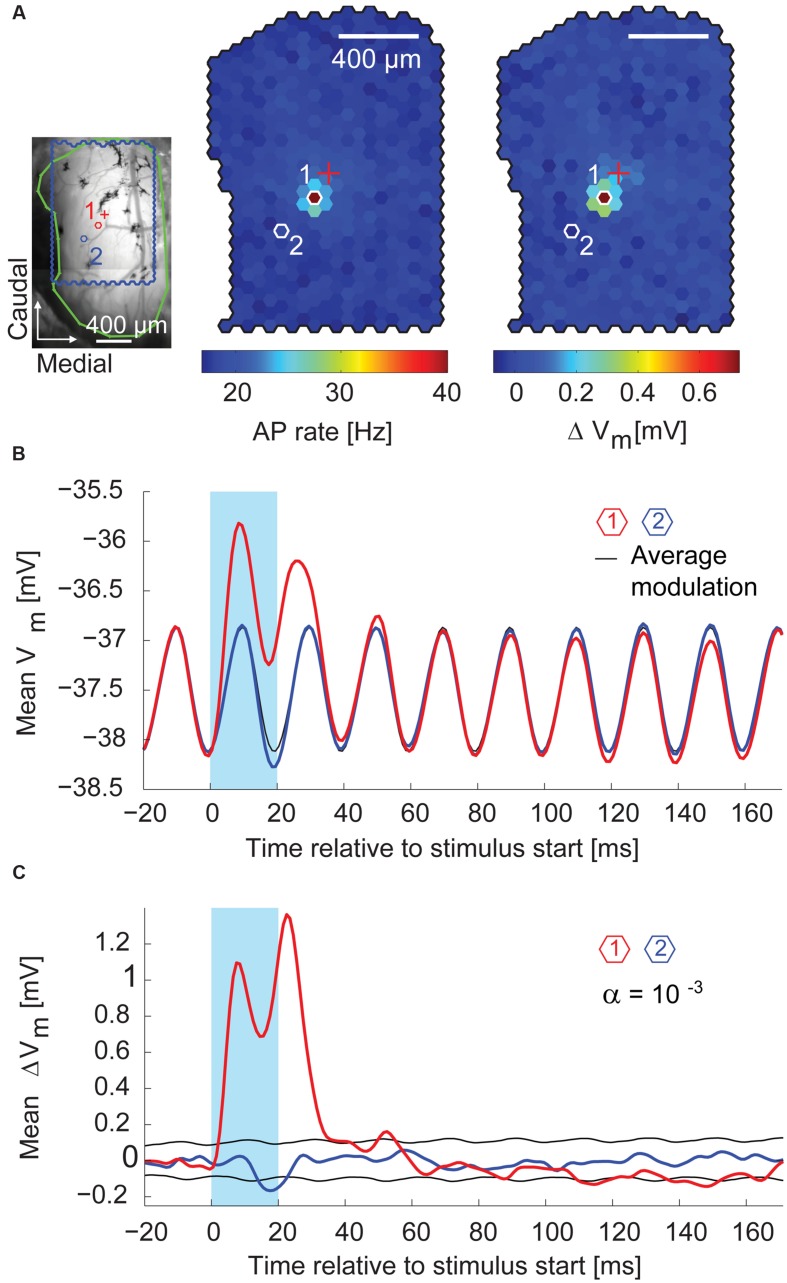
Excitatory and inhibitory effects on the membrane potential. (A)
Left, blood vessel pattern of the dorsal OB with the outline of the stimulated area (blue), electrode position (red cross), and outline of the exposed OB (green). Red (1) and blue (2) hexagons, positions of spots with membrane potential time course in (B). Middle, color-coded map of stimulation efficacy calculated as average AP rate during the 20 ms flash of the individual spots; 3,000 flashes per spot. Right, color-coded map of average membrane potential change during the 20 ms flash of the individual spots. Scale bar 400 μm. (B) Average membrane potential (1 ms time bins, 3,000 flashes per spot) triggered on the onset of the 20 ms stimuli (blue box). Red, stimulation spot (1) with maximal depolarization (hotspot); black, average membrane potential modulation; blue, spot (2) close to the hotspot. See (A) for spot location. (C) Same data as in (B) after subtracting the average membrane potential modulation (black line in B). Black, significance level calculated using shuﬄed data.